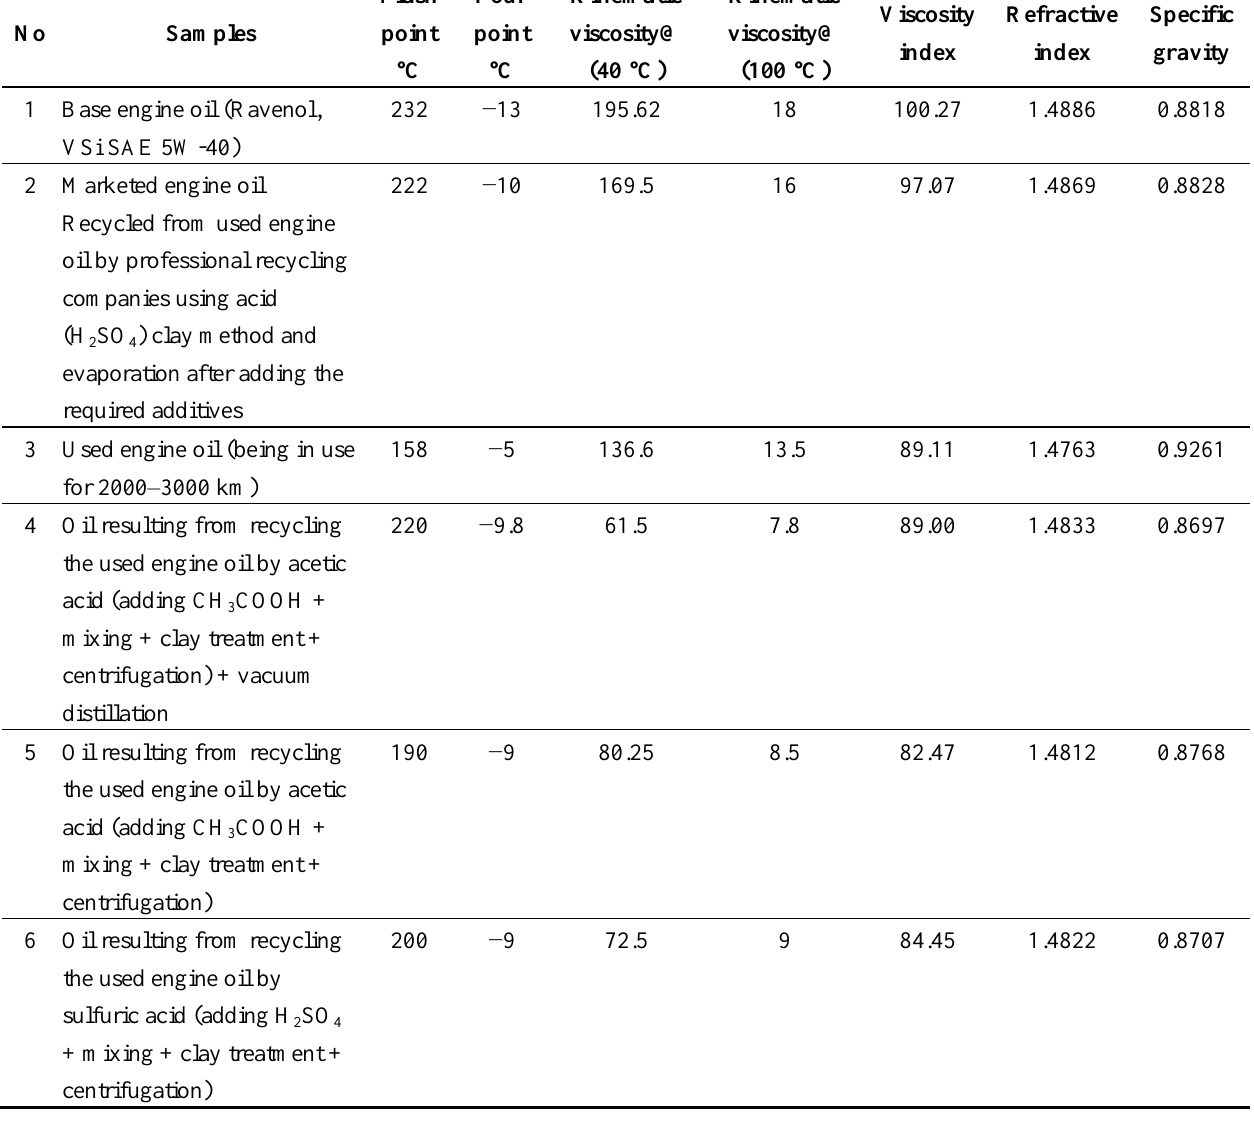
Table 2. Analysis of results of physical and chemical properties of different oil samples.